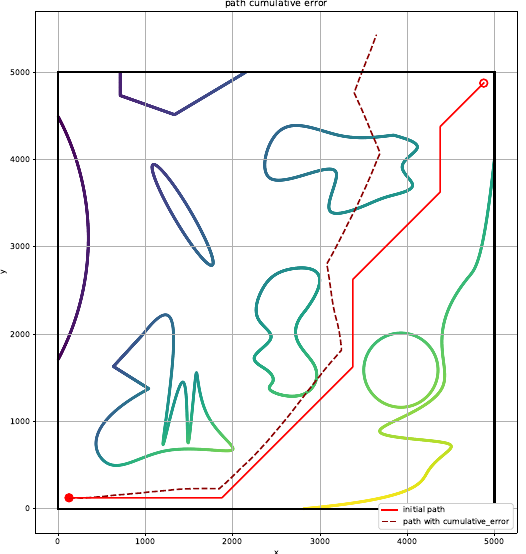
Figure 3. Rasterized map after convex target processing.